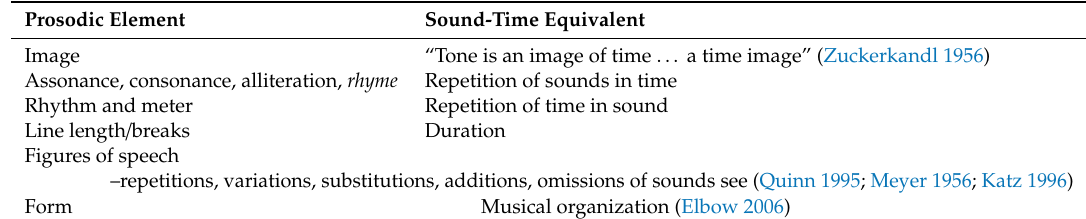
Table 1. Pockets of linguistic time in